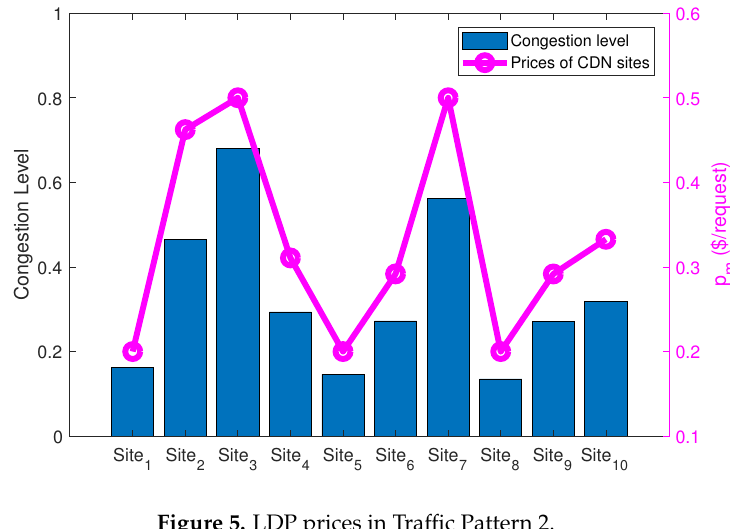
Figure 5. LDP prices in Traffic Pattern 2.